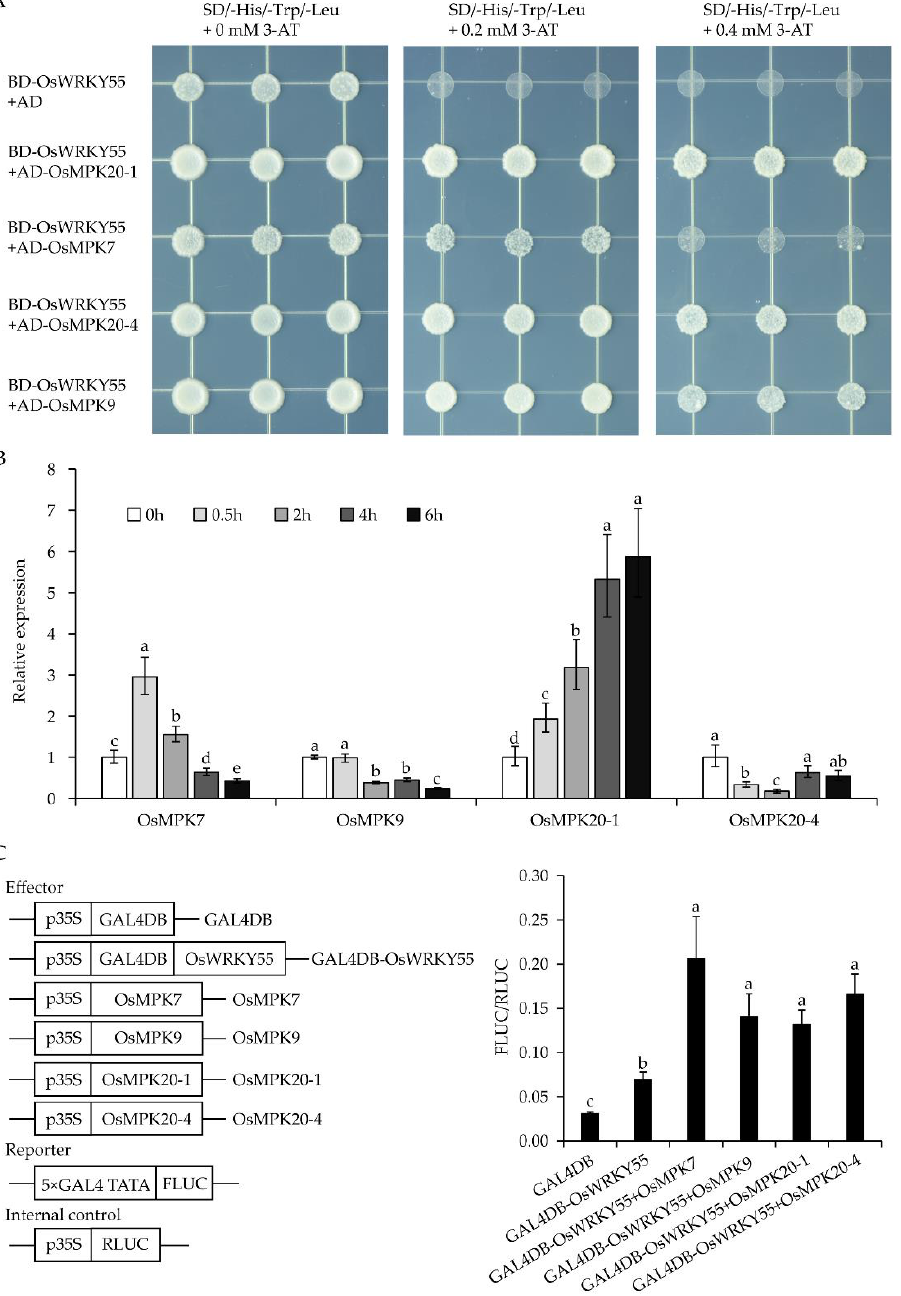
Figure 3. OsMPKs interact with OsWRKY55 and increase its transcription activity. ( A ) The interactions between OsWRKY55 and four OsMPKs in the yeast two-hybrid assays. Growth phenotypes of yeast cells on selective media plates (SD/-Trp-Leu-His) containing 0, 0.2, or 0.4 mM 3-amino-1, 2, 4-triazole (3-AT). ( B ) Relative expressions of OsMPK7 , OsMPK9 , OsMPK20-1 , and OsMPK20-4 after drought treatment (dehydration). ( C ) GAL4-dependent chimeric transactivation assay of OsWRKY55 in rice protoplasts. A schematic illustration of the effector and reporter vectors is shown on the left. FLUC, firefly luciferase; RLUC, renilla luciferase. The right part is the transcription activities by co-transformation of different effector vector(s) with the reporter vector and internal control. Values shown are means ± SD (n = 3). The rice OsActin gene was used as the internal control. Different letters above the bars indicate significant differences ( p <